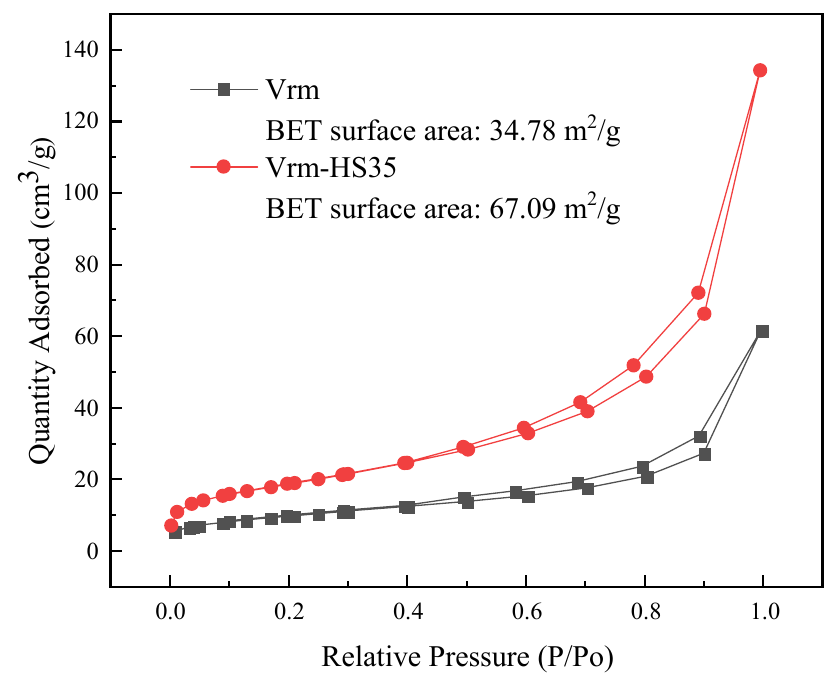
Figure 3. N 2 adsorption/desorption isotherms of Vrm and Vrm-HS35.